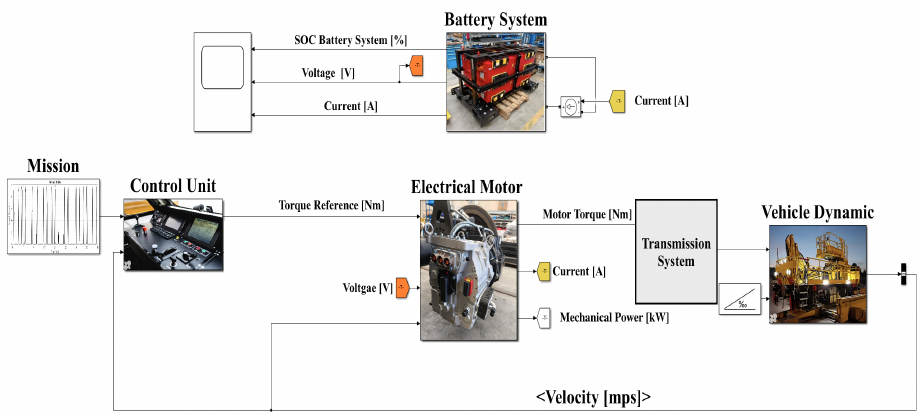
Figure 4. Block diagram of the implemented forward model.